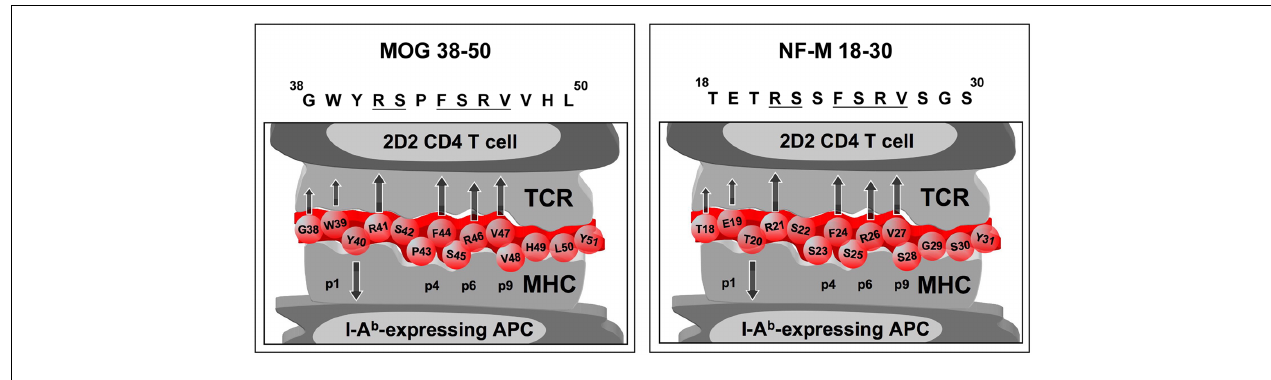
(GWYRSPFSRVVHL) epitopes therefore share keyTCR-contact residues (marked by arrows pointing upward) when presented in the context of I-A b .The residues of the respective peptides interacting with the P1 P4, P6, and P9 pockets of the I-A b are also indicated. Interestingly, although both peptides induce activation of CD4 + T cells from 2D2-TCR RAG − / − mice, the agonistic potential of NF-M18–30 peptide exceeds that of the MOG38–50 peptide, as revealed by proliferation and cytokine release assays.